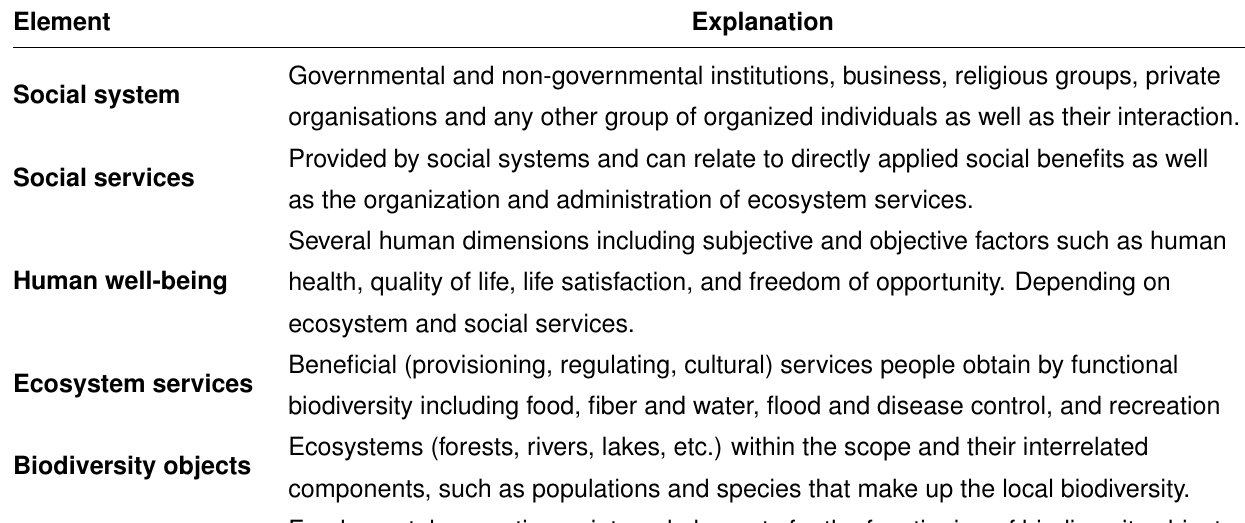
Table 3. Definition of elements comprising the conceptual model determined during the situation analysis.